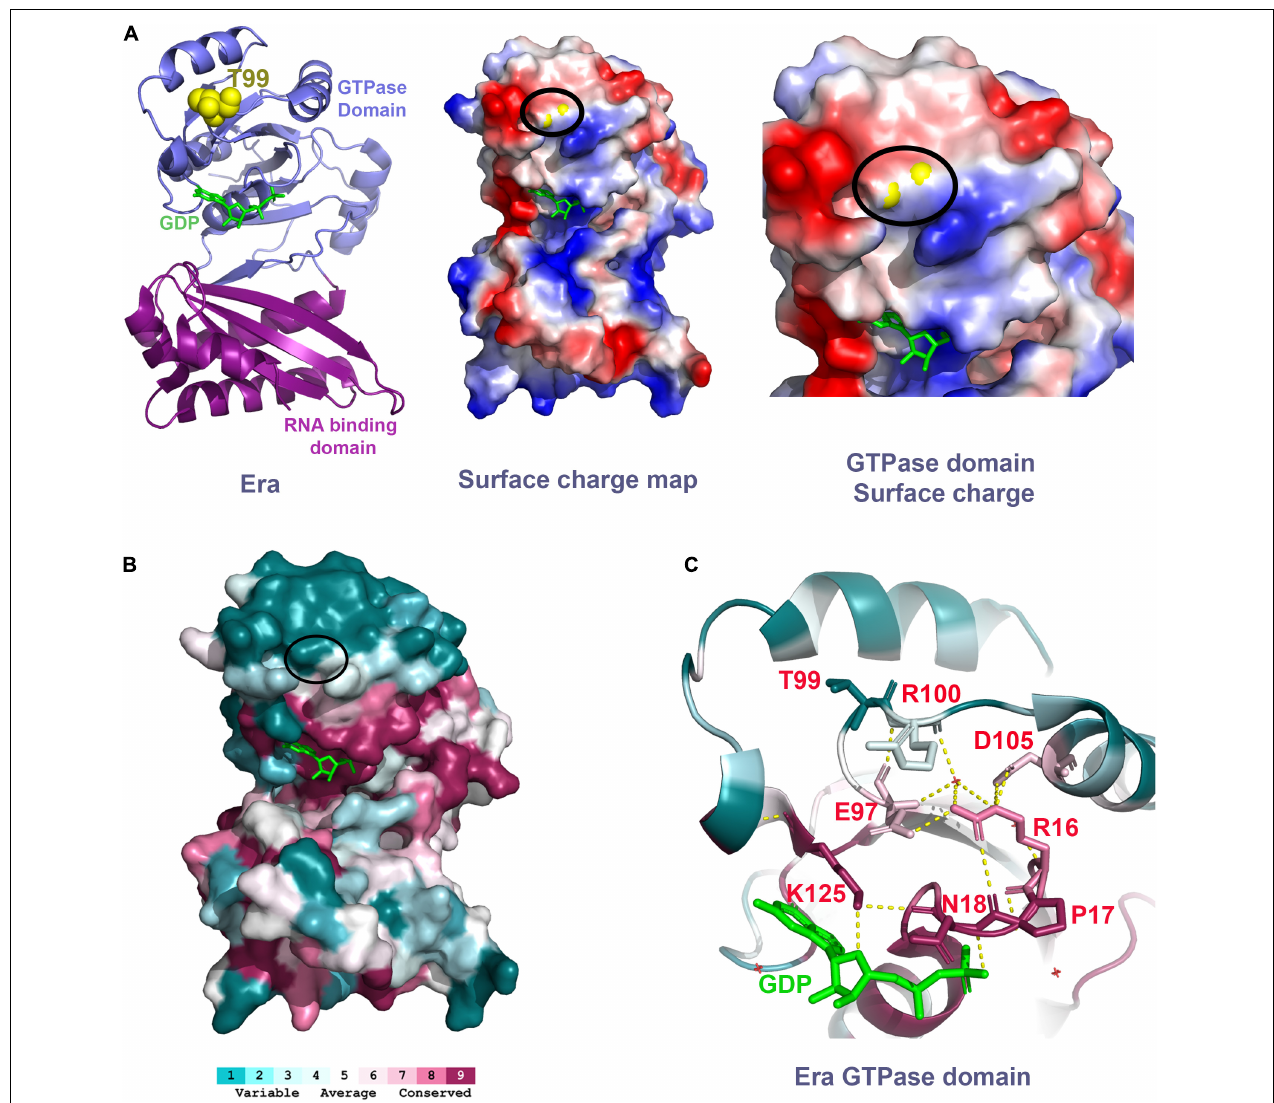
FIGURE 8 | (A) Left panel shows the Era structure (PDB: 3IEU) with T99 residue (yellow spheres) and GDP (green). Middle panel shows the charge distribution of the Era protein at the surface that has the T99 residue (yellow spheres within the black oval). Right panel shows the close-up view of the GTPase domain with the T99 residue (yellow spheres within the black oval). Negative charge – Red. Positive charge – Blue. (B) Era protein surface colored based on the conservation scores obtained using ConSurf tool. Black oval highlights the location of the T99 residue. (C) Polar interactions between the residues highlighted (sticks, red labels) are indicated as the dashed yellow